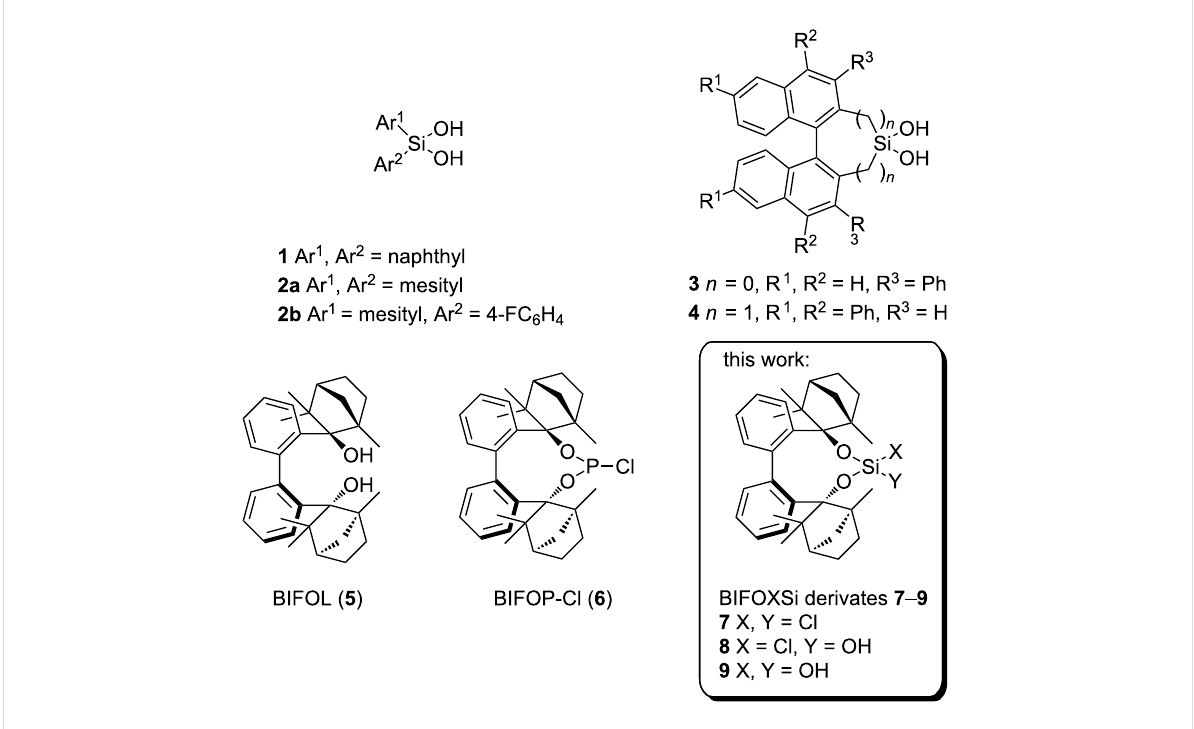
Figure 1: Hydrogen-bonding silanediols, i.e., di(1-naphthyl)silanediol ( 1 ) [39], silanediols 2 [41-43], binaphthylsilanediol derivatives 3 [45,46] and 4 [47,48] and novel biphenyl-2,2’-bisfenchyloxydichlorosilane ( 7 ), biphenyl-2,2’-bisfenchyloxychlorohydroxysilane ( 8 ) and biphenyl-2,2’-bisfenchyloxysi- lanediol ( 9 ) with precursor BIFOL ( 5 ) [52] and phosphite derivative BIFOP-Cl ( 6 ) [53].